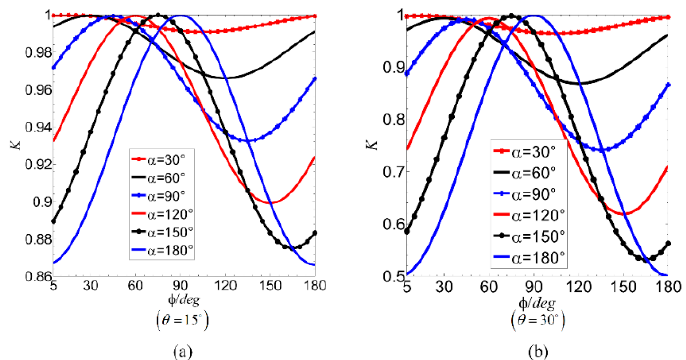
Figure 2. The relationship between the contrast and the polarization angle combinations with 6 azimuth angles. The interference contrast is most affected by polarization when the azimuth angles are orthogonal. The greater the incident angle, the greater the contrast loss caused by the polarization. For ( a ), the incident angle is 15°, and for ( b ), the incident angle is 30°. Substituting Equation (11) into Equation (10), the maximum contrast that can be achieved by double-beam interference is